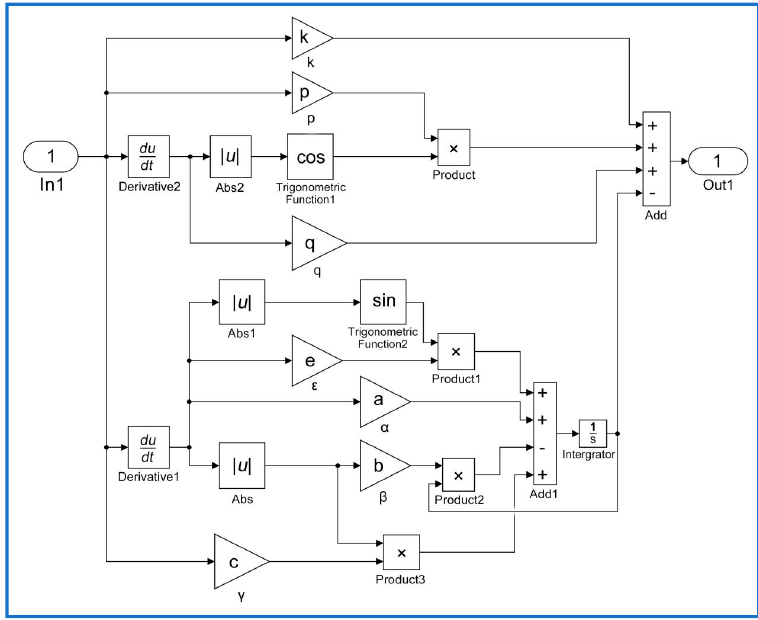
Figure 4. Modified Duhem model implemented with Matlab/Simulink.